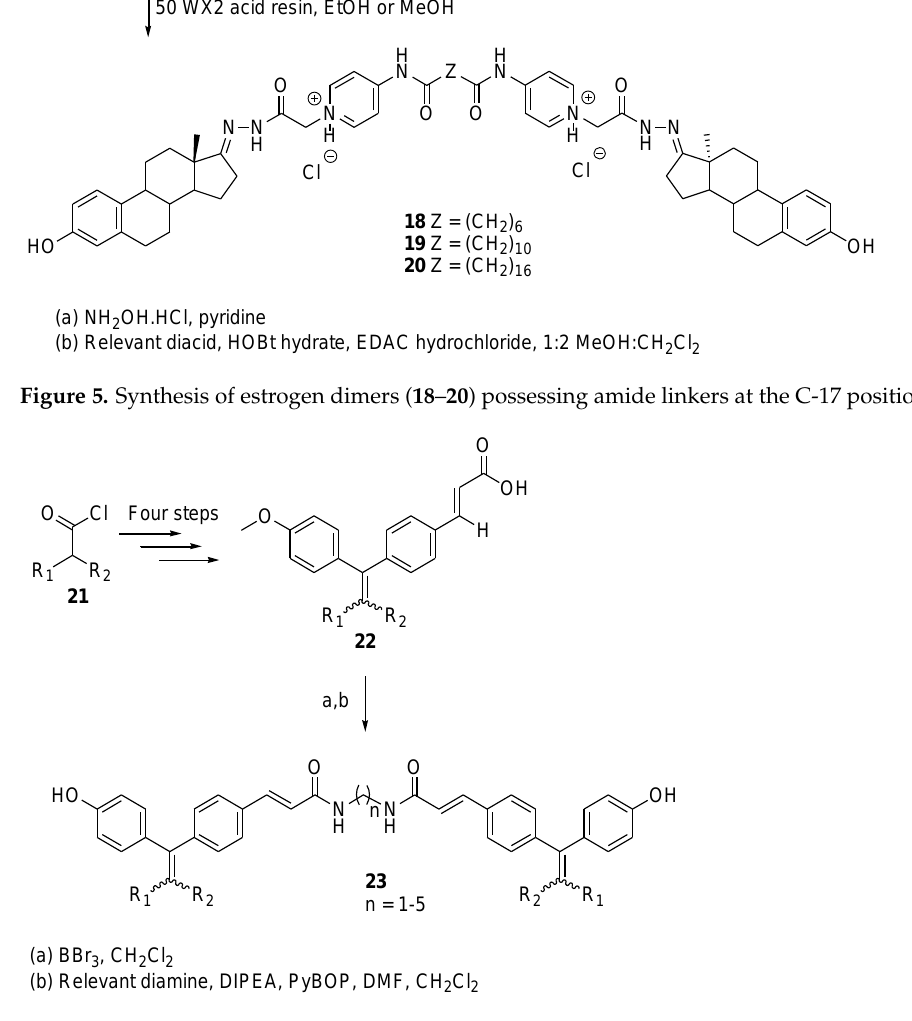
Figure 6. Synthesis pathway of the estrogen receptors antagonist ( 23 ) with corresponding starting materials ( 21 ).